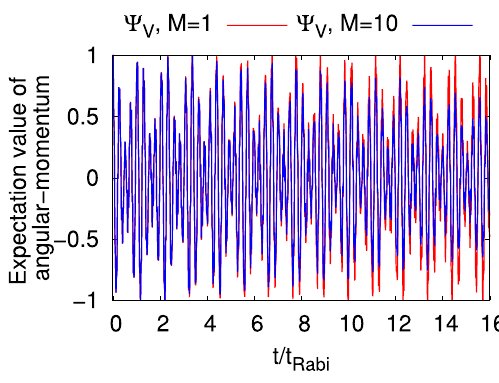
1 (cid:31) V (cid:31) V L Z , in a symmetric |ˆ | � N � 10 bosons. Mean-field ( M 1 time-adaptive orbitals) result = = 10 time-adaptive orbitals) in blue. See the text =